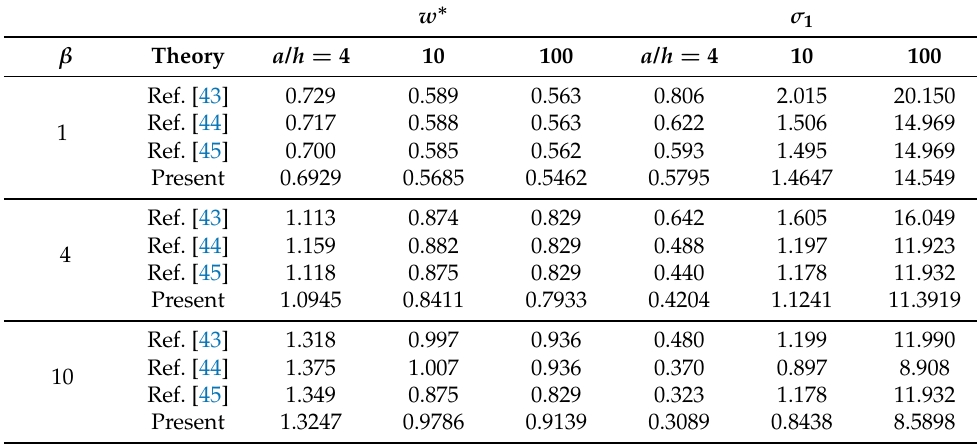
Table 2. Nondimensionalized deflection w ∗ ( 0 ) of and the in-plane normal stress σ 1 ( h /3 ) in FG square plates under sinusoidal